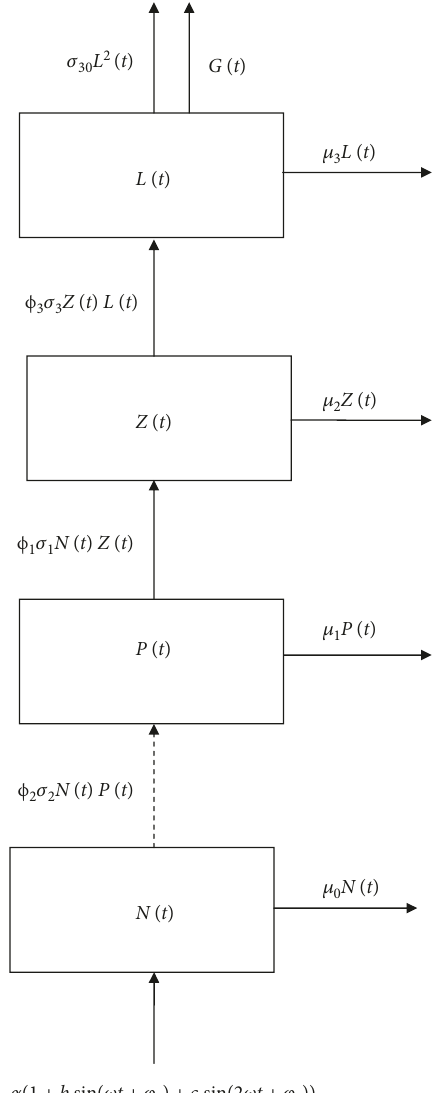
Figure 4: Flow diagram of the Limnothrissa miodon model with